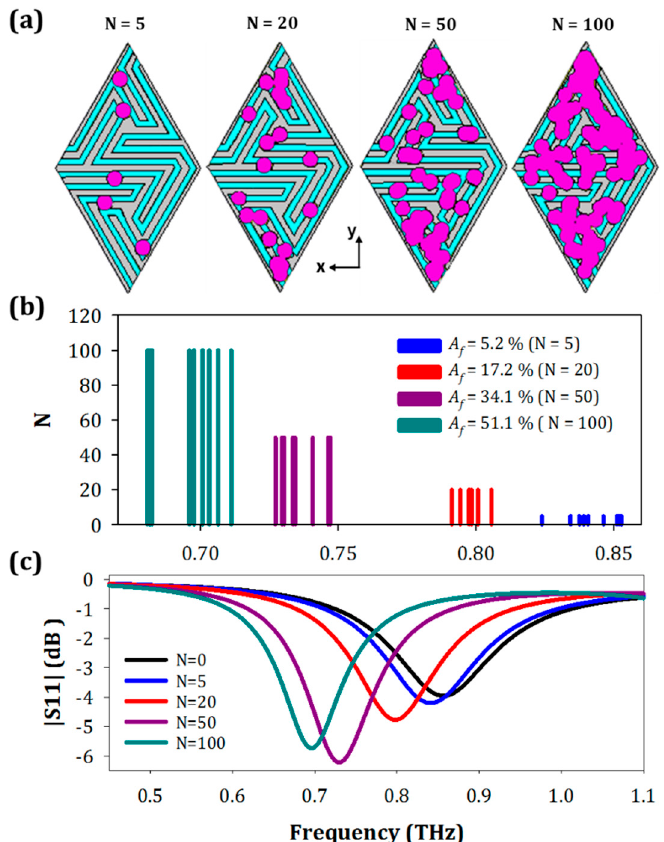
Figure 2. ( a ) Front view of the structure with N = 5; 20; 50; 100 fungi (purple cylinders). ( b ) Resonance frequency for all the simulations carried out for different fungi concentrations: N = 5 (blue curve), N = 20 (red curve), N = 50 (purple curve), and N = 100 (dark cyan curve). ( c ) Reflection coefficient for different fungi concentrations, cases nearest to the mean values.